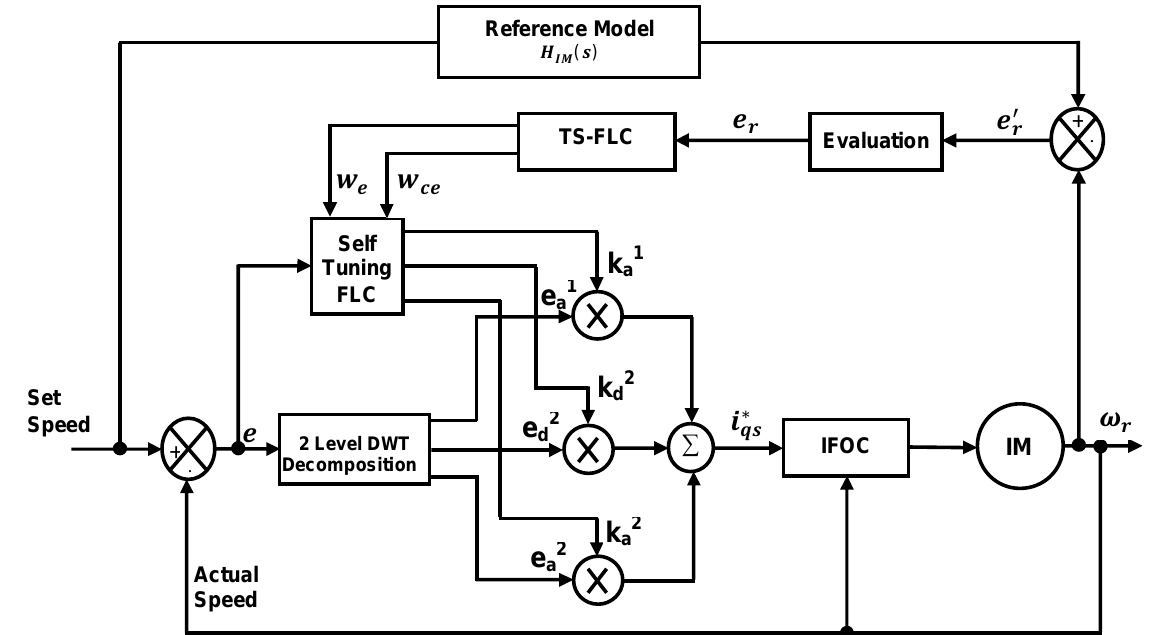
Fig. 3. Schematic of Wavelet Fuzzy based Speed